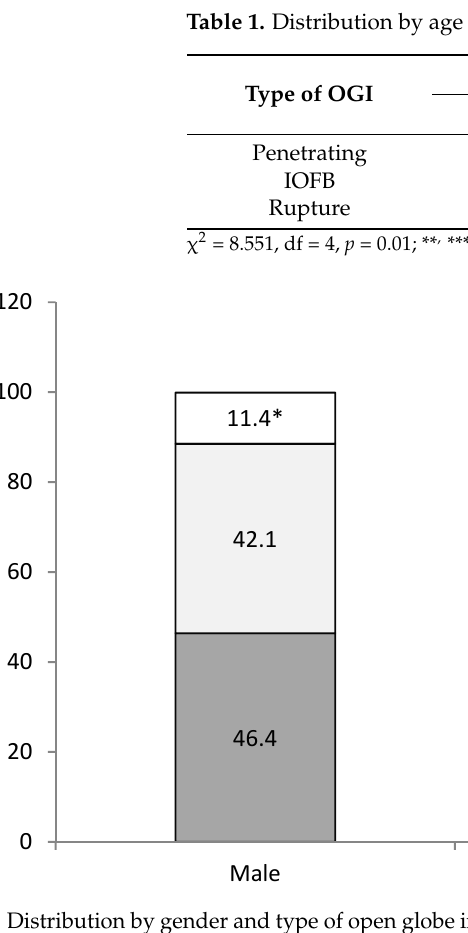
Table 1. Distribution by age and type of open globe injury (OGI).